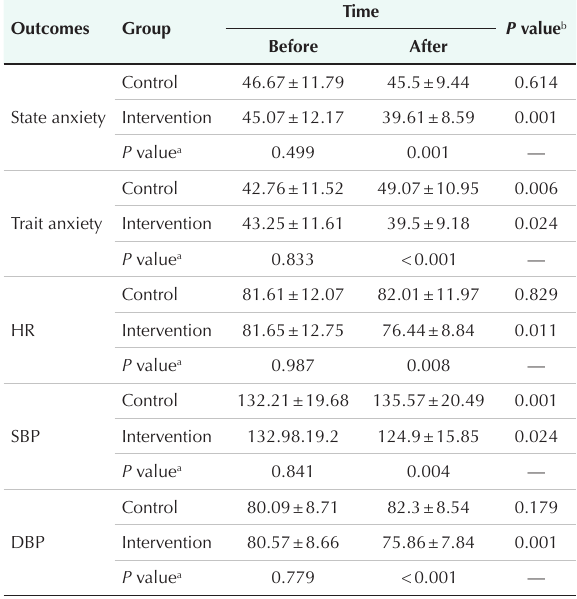
Table 3 . Within- and between-group comparisons respecting the means of state and trait anxiety and hemodynamic parameters Outcomes Group